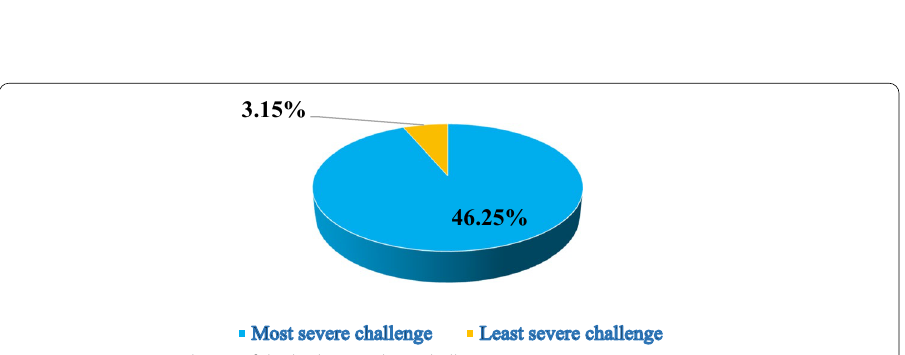
Fig. 15 Severity correlation of the highest ranking